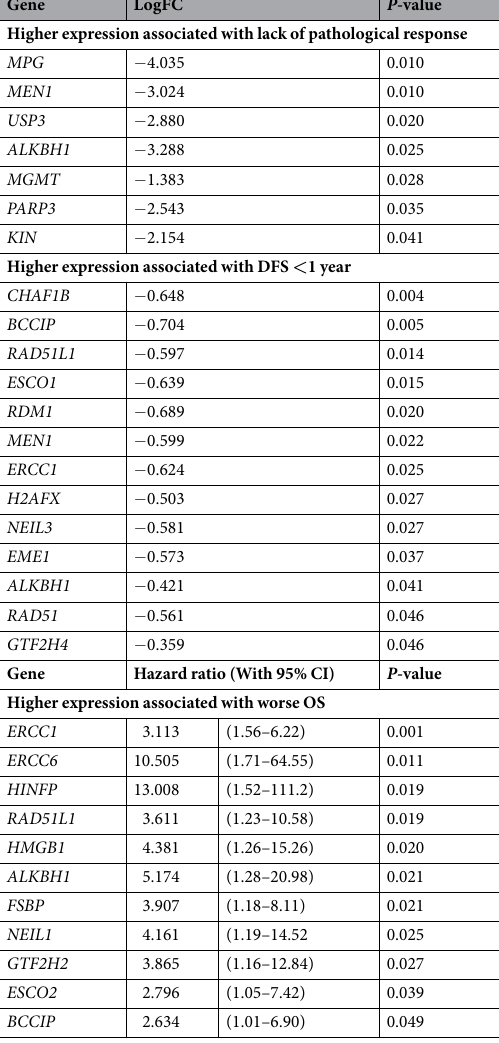
Table 2. Significant associations between pre-treatment DNAR gene expression and pathological response, disease free survival or overall survival. Principal component analysis was carried out to ensure that tumor and non-malignant epithelium showed segregation and to check for any technical artifacts. Differential expression (log fold change) of DNAR genes in tumor tissue from 38 patients with esophageal adenocarcinoma was compared between pathological non-responders and pathological responders, and between patients with DFS < 1 year and DFS > 1 year, using linear regression. Pre-treatment gene expression levels significantly associated with OS were identified by Cox proportional hazards regression. Unadjusted P values are presented to enable identification of all hits appropriate for hypothesis testing and subsequent validation, albeit with recognized risk that some of the hits might appear by